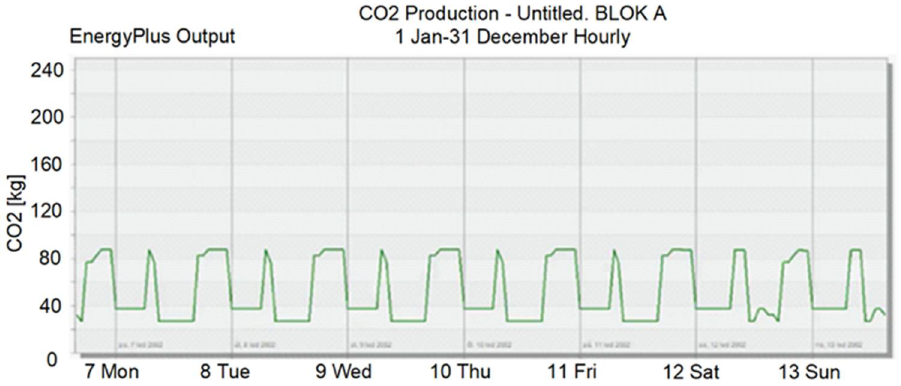
Figure 12. CO 2 production of Block A before reconstruction in winter for a week.